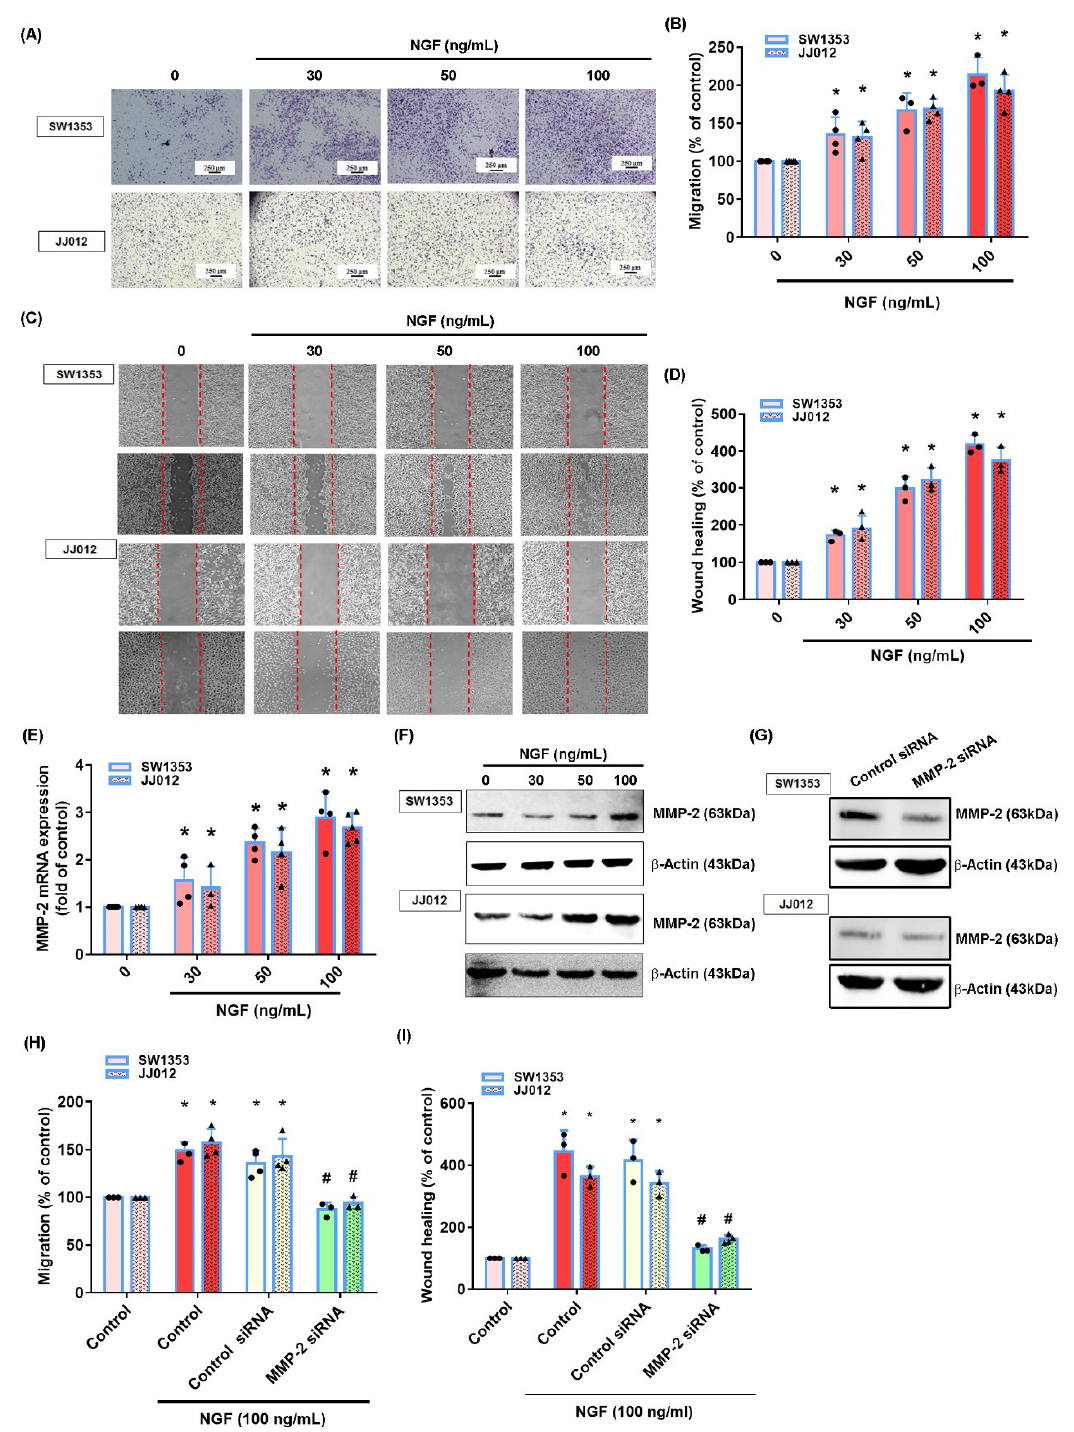
Figure 2. NGF promotes MMP-2-dependent cell migration in a human chondrosarcoma. ( A – D ) Cells were incubated with NGF (30–100ng/mL) and the cell migration was examined by Transwell and wound healing assays. ( E , F ) Cells were incubated with NGF (30–100ng/mL) and the levels of MMP-2 mRNA and protein expression were examined by qPCR and Western blot assays. ( G – I ) Cells were transfected with MMP-2 siRNAs then stimulated with NGF. The cell migration and MMP-2 expression levels were examined by Transwell, wound healing and Western blot assays. * p < 0.05 compared with the control group; # p < 0.05 compared with the NGF-treated group.